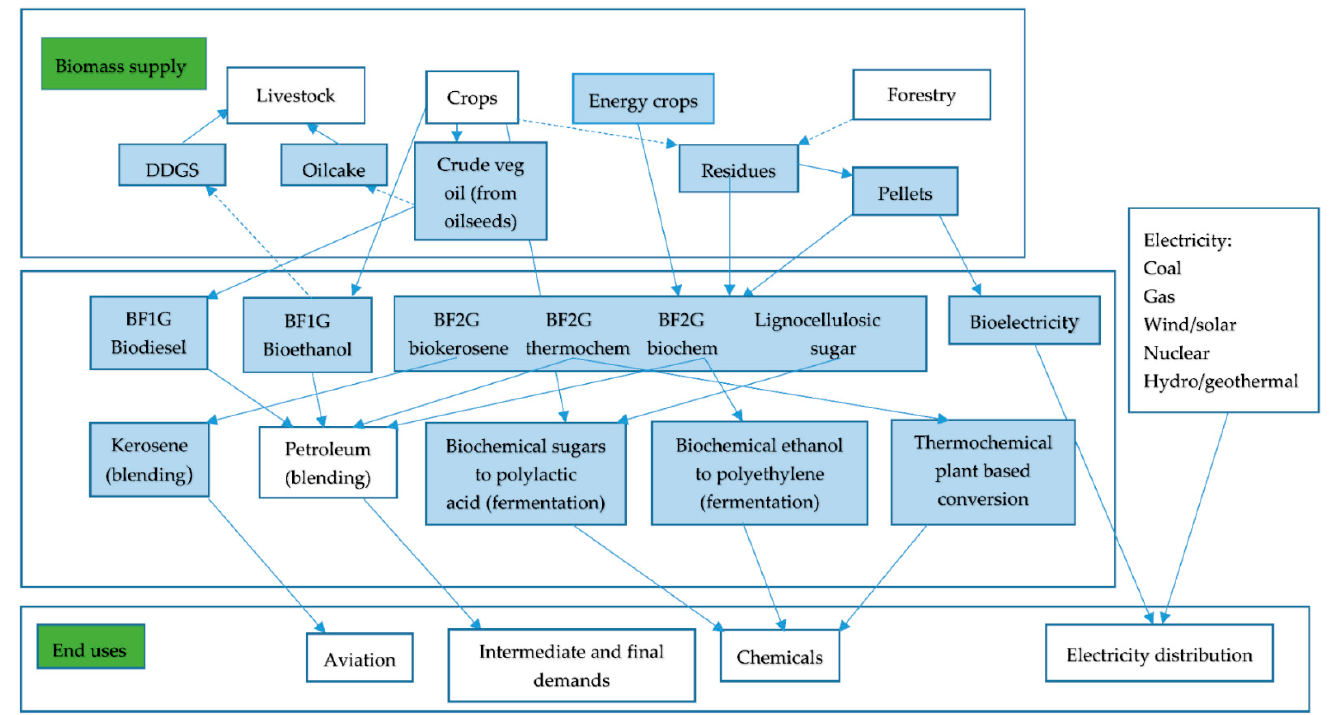
Figure 1. Overview of bi o-based sectors and linkages in MAGNET.